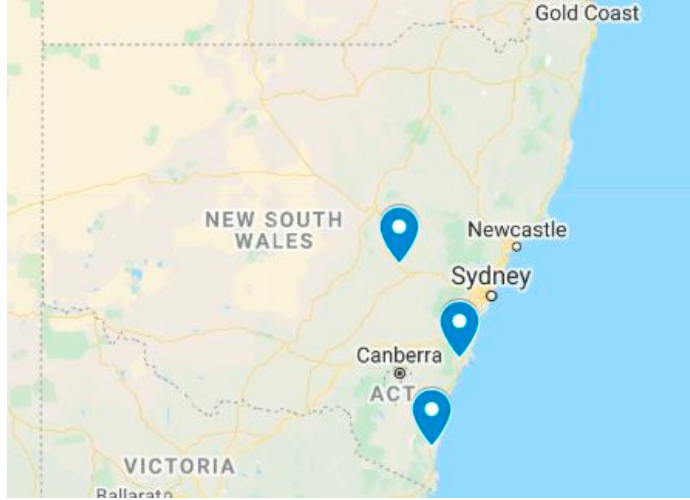
Figure 1. Geographical locations of three case studies in New South Wales, Australia. Table 1. Overview of each